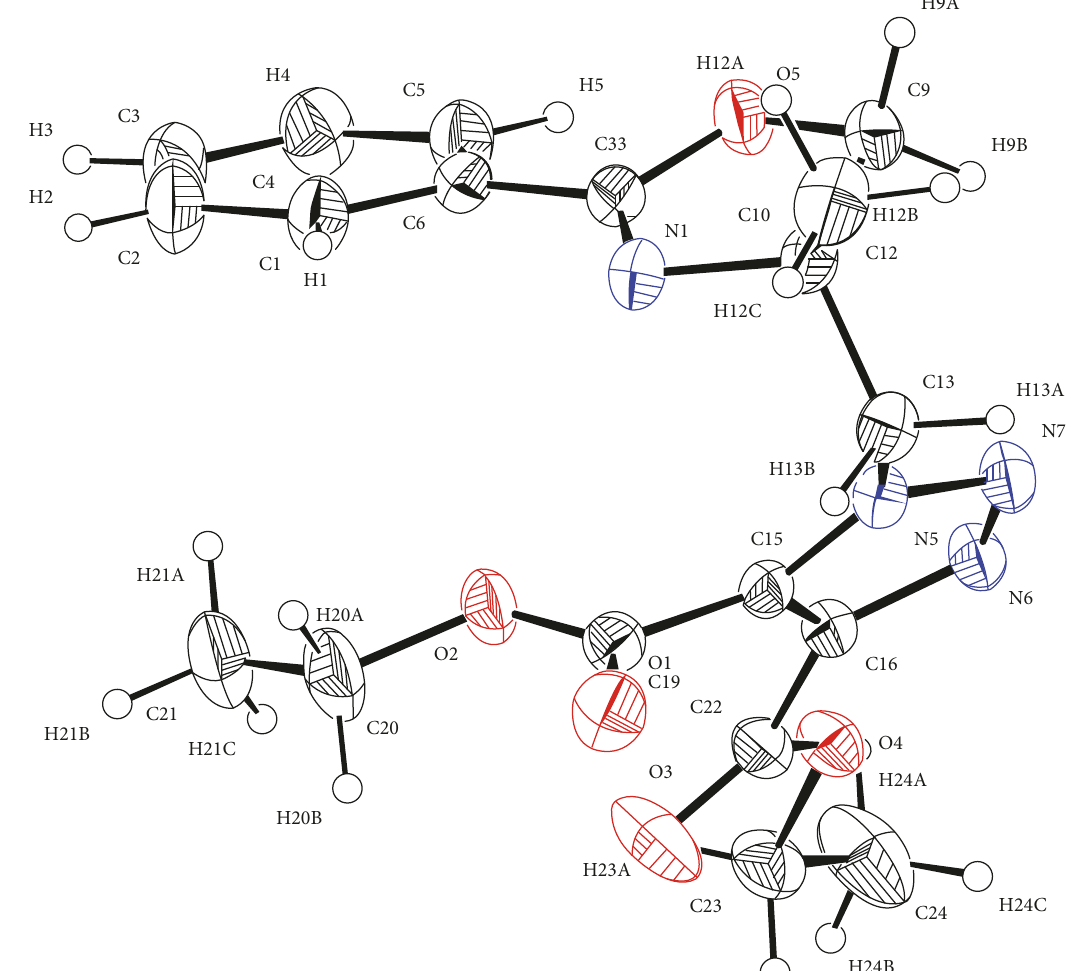
Figure 3: Molecular structureof compound showing the atom numbering scheme. H atoms are represented as small spheres of arbitrary radii.